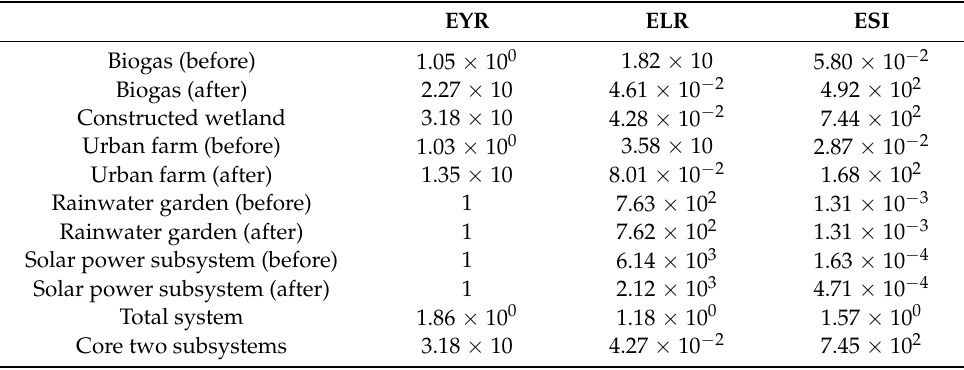
Table 11. Emergy calculation of the complete Urban Self-circulation